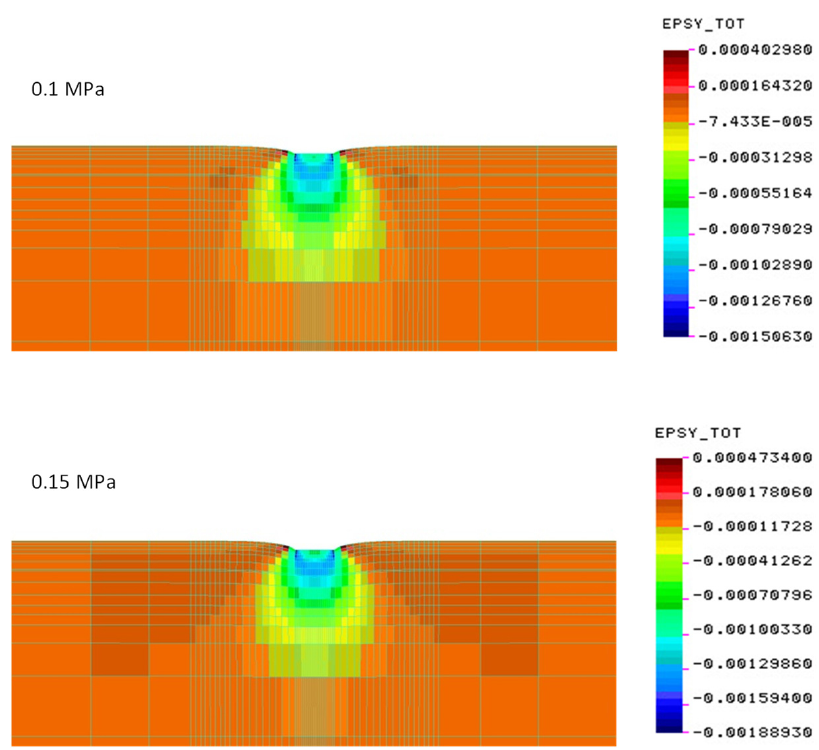
Figure 12. Vertical deformations on the cement-stabilized subgrade—construction No. 2 (deformation scale ×100).